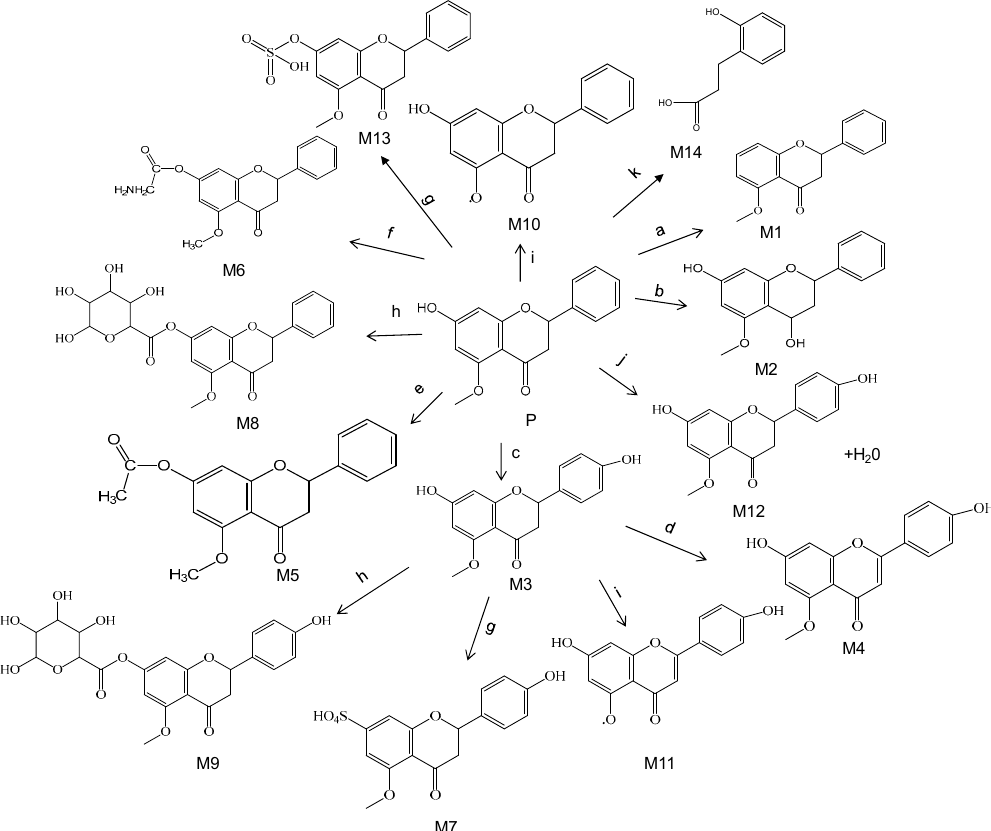
Figure 1. Proposed metabolic pathway of alpinetin in rats after oral administration. ( a . Deoxydation; b . Reduction; c . Oxidation; d . Desaturation; e . Acelylation; f . Glycine conjugation; g . Sulfation; h . Glucuronide conjugation; i . Demethylation; j . Hydration; k . cleavage).